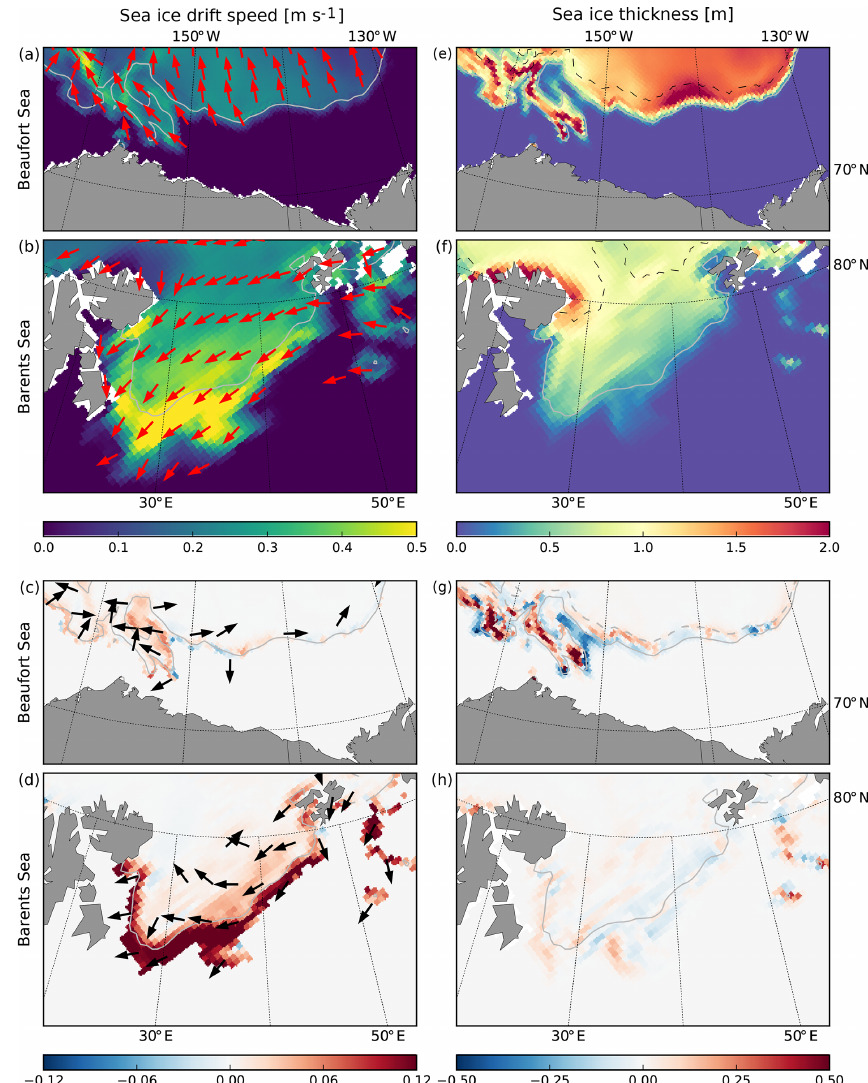
Figure 12. Mean sea ice drift (a, b) and sea ice thickness (e, f ) simulated by the CPL run during the storms that occurred in the Beaufort Sea (a, e) and in the Barents Sea (b, f) on 16–17 August 2010. Panels (c, d, g, h) show the differences for these quantities between the CPL and NOT_CPL simulations. Grey contours indicate the position of the ice edge determined from the averaged sea ice concentration ( c = 0 . 15). The dashed black contour delimits the border between broken and unbroken ice ( D max =